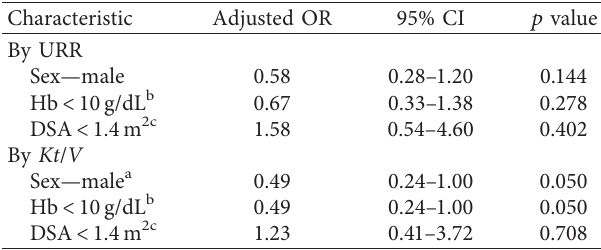
Table 4: Logistic regression analysis for factors with inadequate